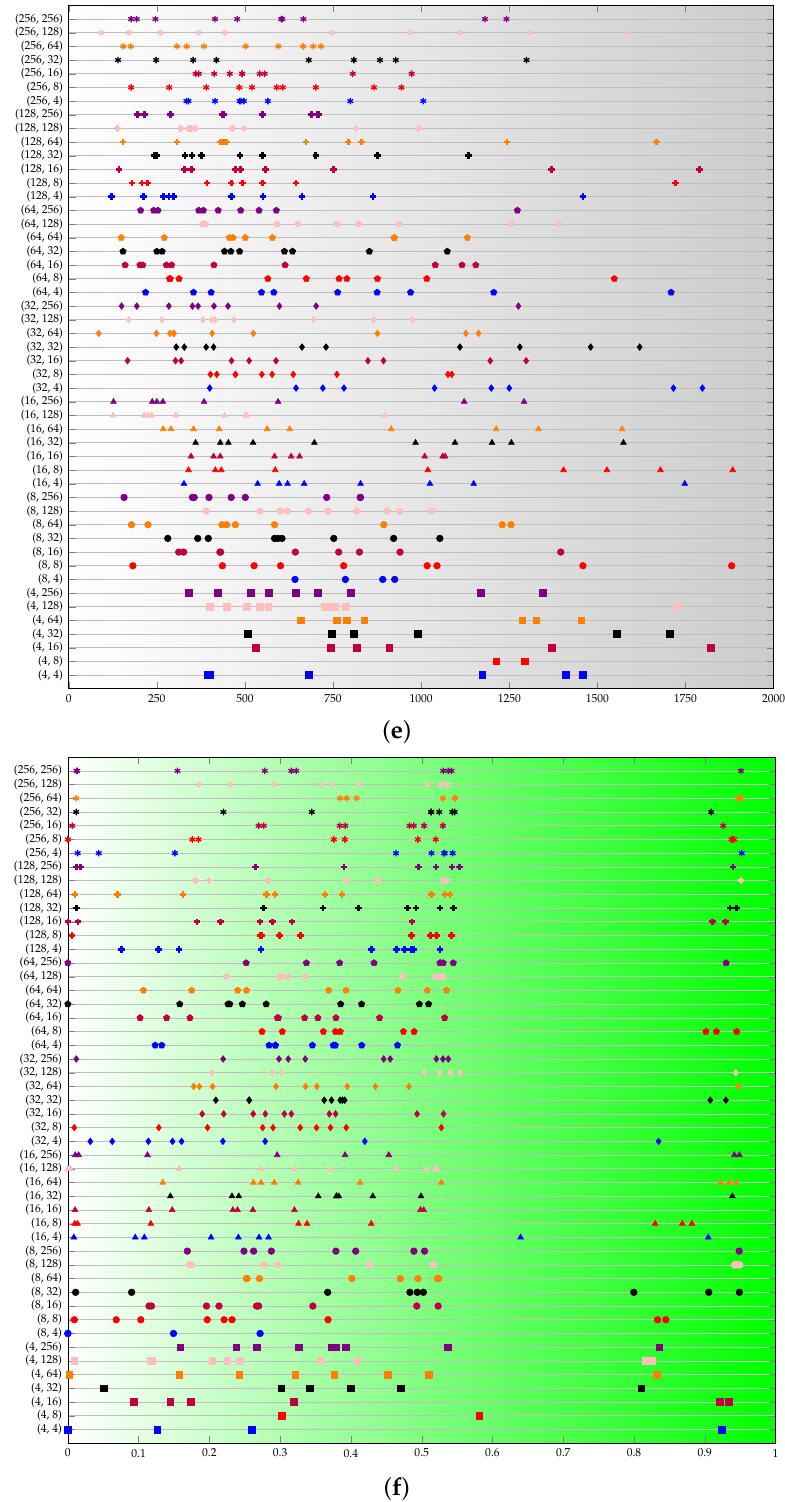
FigureA2. ThetestsetBprovidesasensitivityanalysisonthediscriminatorsize. InSubfiguresA2a-A2dtherowsrepresent H 1 and Figure A2. Test set B provides a sensitivity analysis on the discriminator size. ( a – d ) The rows thecolumns H 2 . InSubfiguresA2e-A2f,thecouplesontheverticalaxisare ( H 1 , H 2 ) ,markershapesrepresent H 1 andmarkercolors represent H 1 and the columns H 2 . ( e , f ) The couples on the vertical axis are ( H 1 , H 2 ) . Marker shapes represent H 2 . represent H 1 and marker colors represent H 2 . ( a ) Converging runs, out of 10. ( b ) Number of epochs before convergence, on average. ( c ) p -value for the χ 2 test once convergence is reached (average over converging runs). ( d ) p -value for the χ 2 test once convergence is reached (best run). ( e ) Visual representation of the epochs before convergence. ( f ) Visual representation of the p